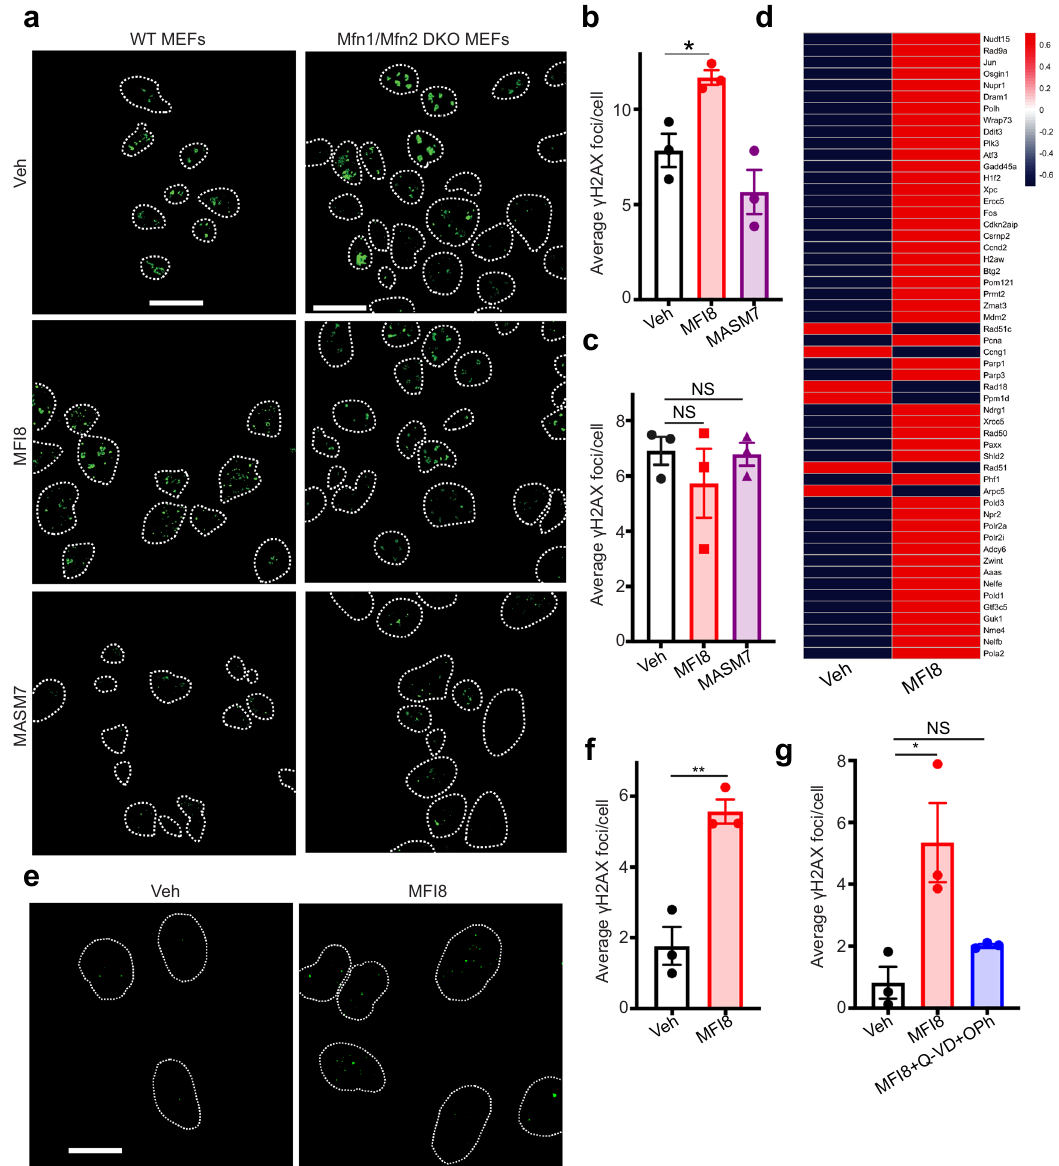
Fig. 6 MFI8 induces DNA damage. a MEFs and Mfn1/Mfn2 DKO MEFs were immunostained for γ H2AX. Cells were treated with MFI8 (20 μ M, 6 h)